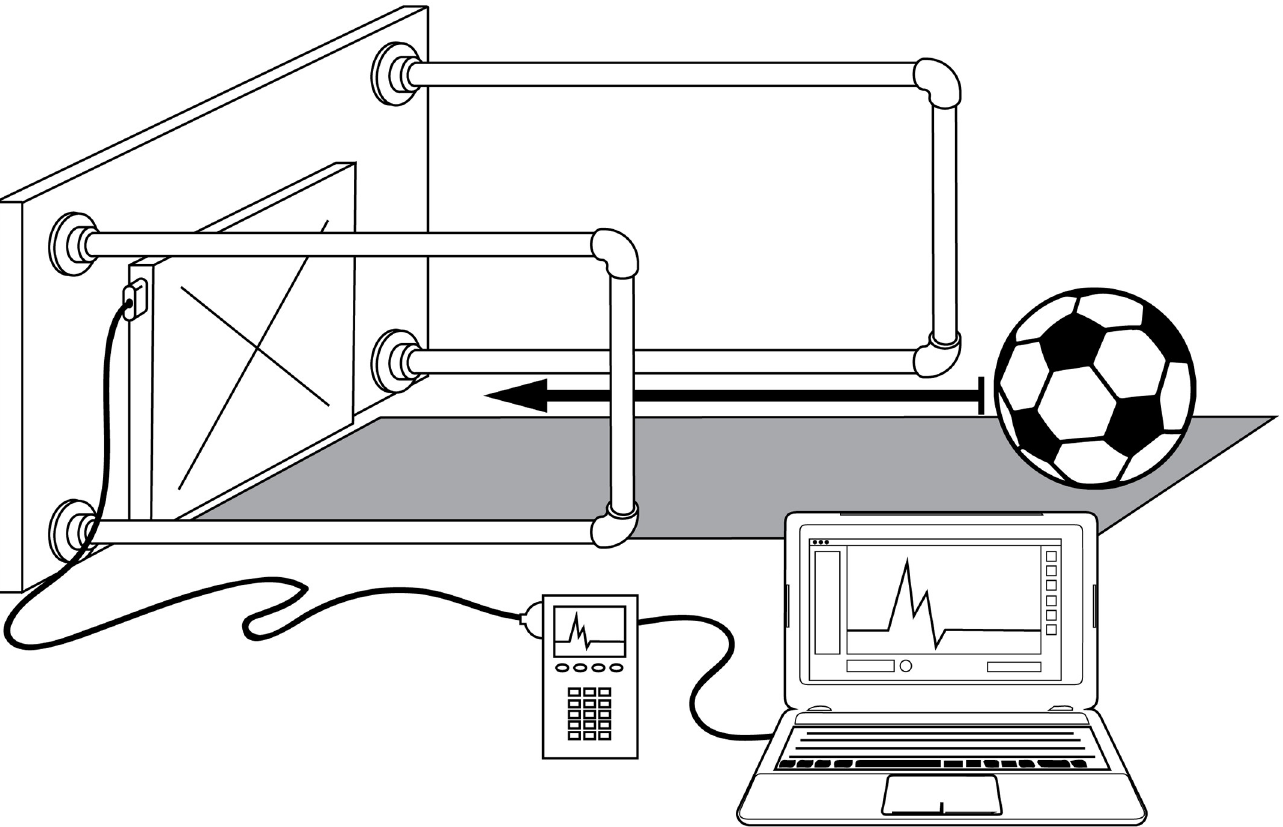
Fig 1. Experimental set-up used for each kick of a soccer ball. The vertically mounted force plate collected impact force data through the PASCO Xplorer GLX ™ sensor receiver unit connected to a laptop running PASCO Capstone Software ™ [29]. A camera mounted on a crossbar above the force plate captured impact motion for calculating ball